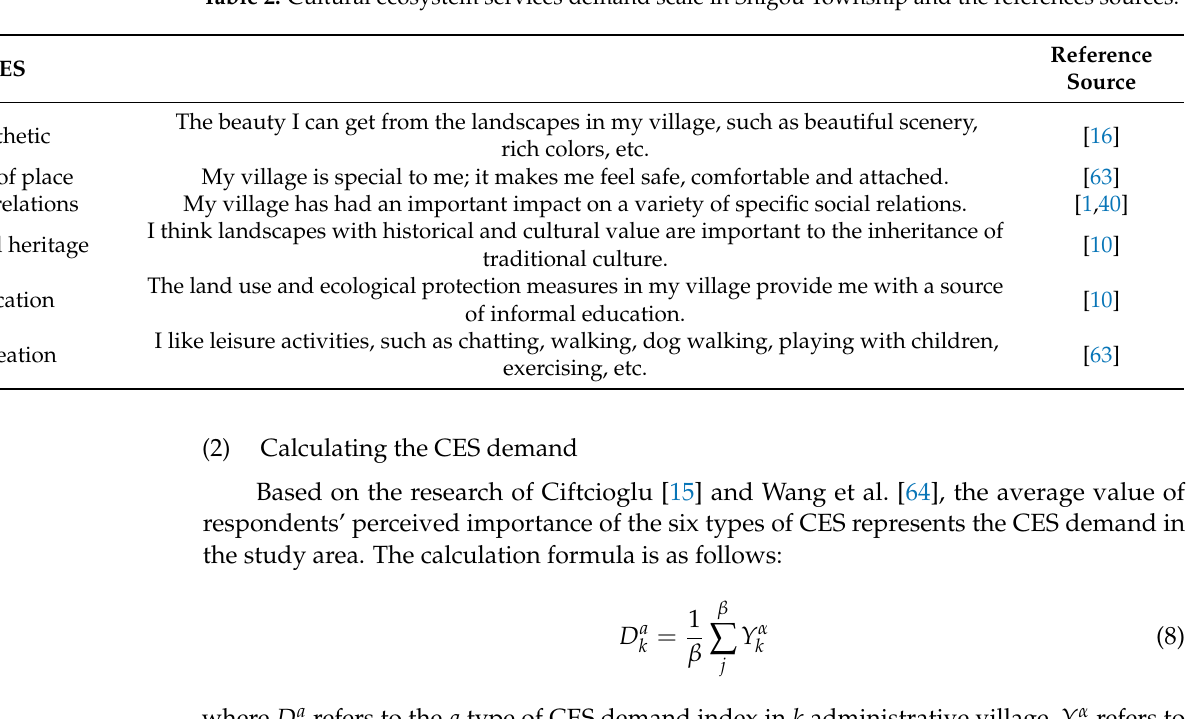
Table 2. Cultural ecosystem services demand scale in Shigou Township and the references